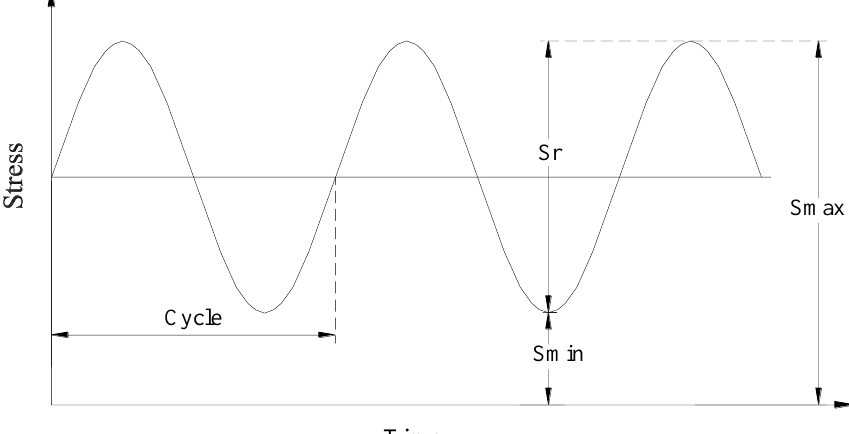
Fig. 5. An illustration of a stress history under constant amplitude loading.